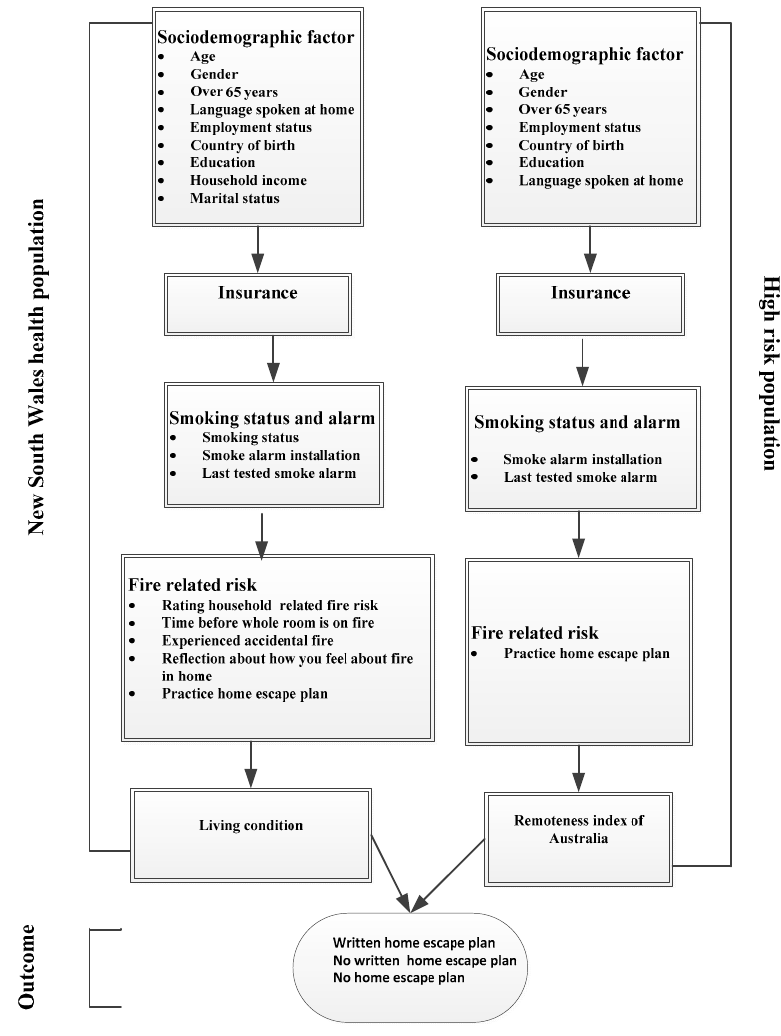
Figure 1. Conceptual model